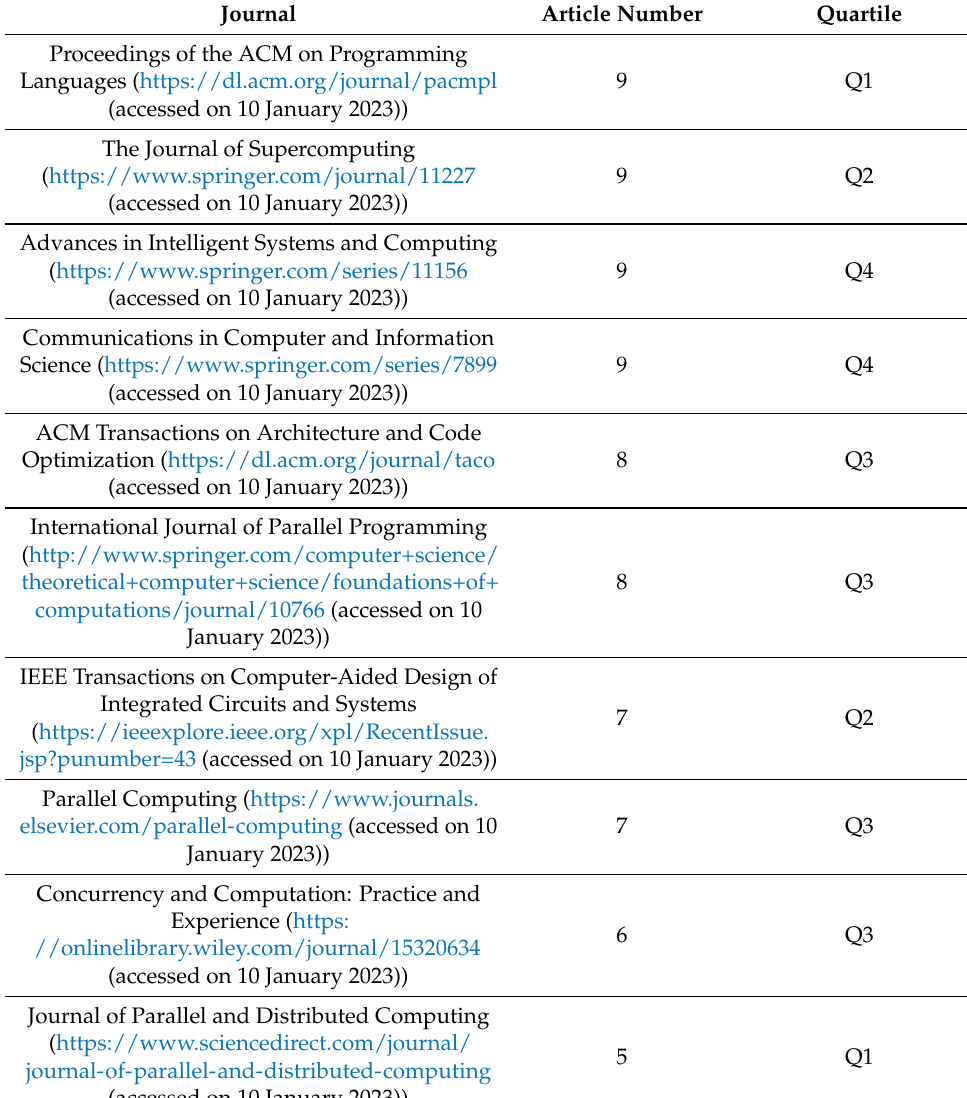
Table 8. Top 10 most-used